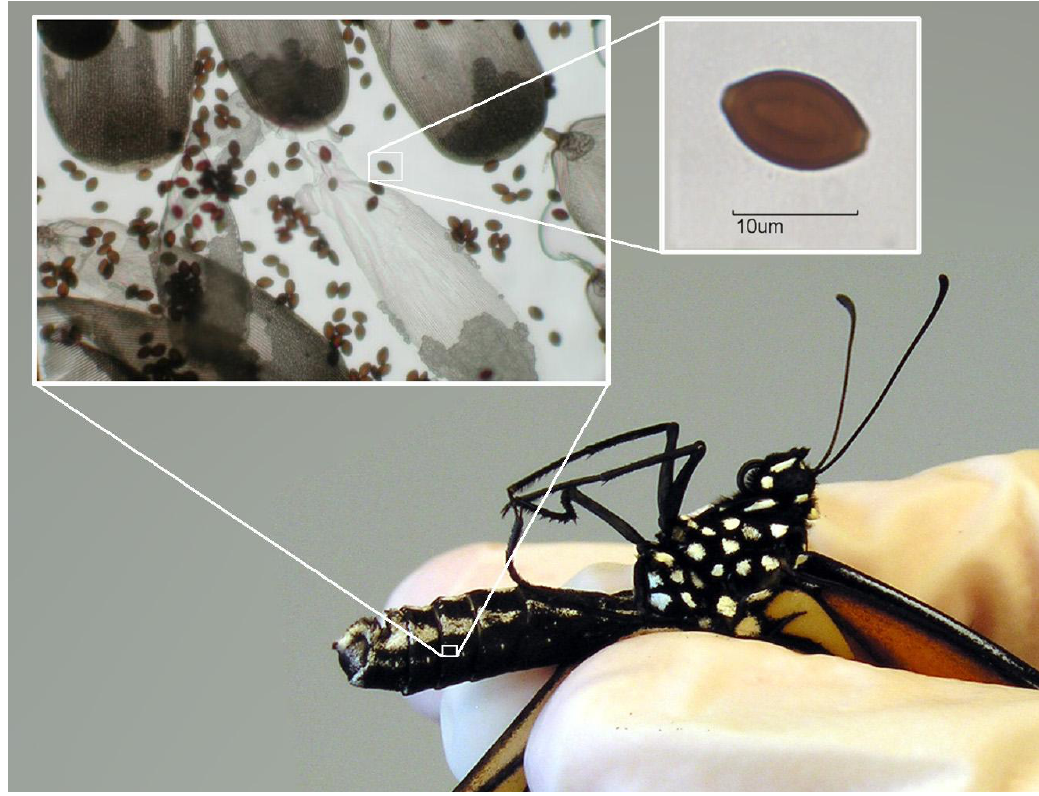
Figure 1. Ophryocystis elektroscirrha ( OE ) infection of a monarch butterfly. Adult monarchs emerge covered with millions of dormant, lemon-shaped, amber-walled spores (inset figure) on their abdomen. Small inset figure: A single spore showing correct 2D orientation to the field of view for morphometric